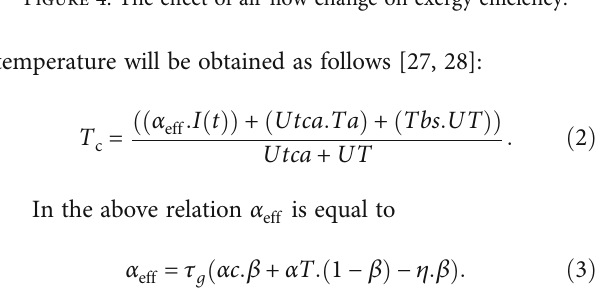
Figure 1: Exergy analysis.